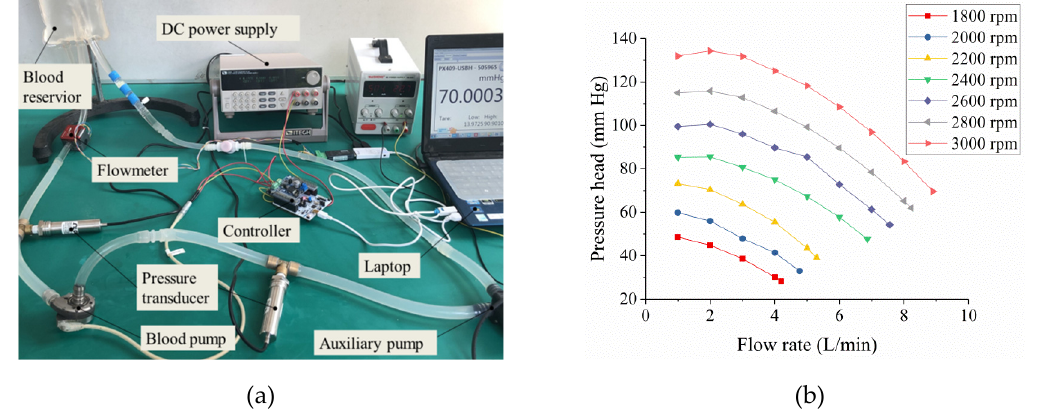
Figure 4. ( a ) An experimental platform for testing the hydrodynamic characteristics of blood pumps. ( b ) Pressure head versus blood flow rate curve. ( b ) Pressure head versus blood flow rate